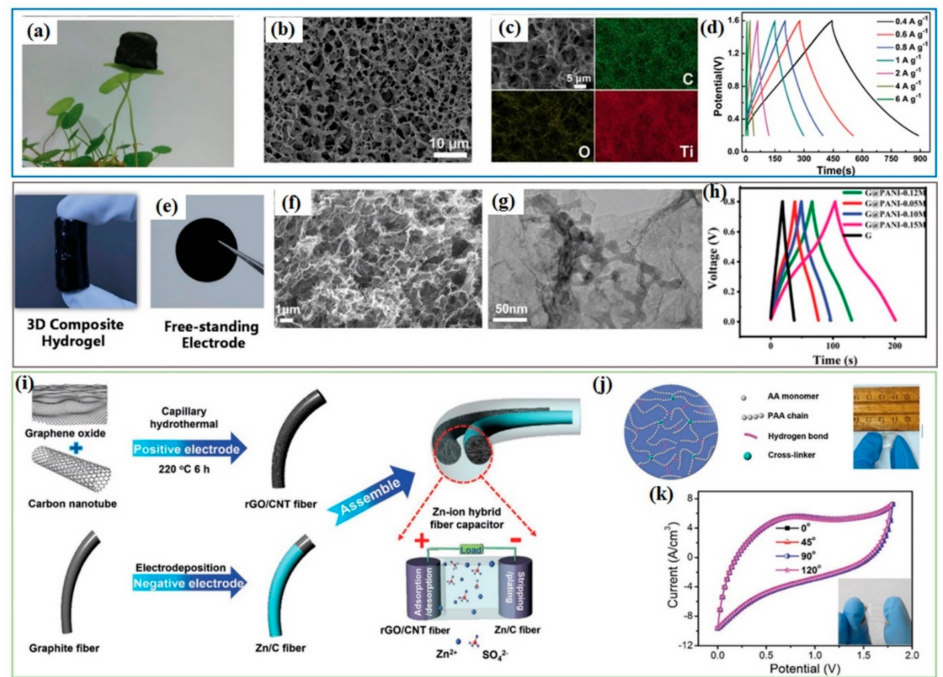
Figure 9. Graphene composites as cathodes for Zn-ion hybrid capacitors. ( a – d ) MXene@rGO aerogel for Zn-ion hybrid capacitors: ( a ) MXene-rGO aerogel standing on a piece of leaf, ( b ) SEM image, ( c ) EDS mapping, and ( d ) charge–discharge curves at current densities from 0.4 to 6 A g − 1 . Reproduced with permission [83], Copyright 2019, Wiley-VCH. ( e – h ) PANI@graphene hydrogel for a Zn-ion hybrid capacitor: ( e ) optical images of a 3D graphene hydrogel cylinder and the free-standing electrode film, ( f ) SEM and ( g ) TEM images of PANI@graphene, ( h ) galvanostatic charge–discharge profiles. Reproduced with permission [26], Copyright 2018, Royal Society of Chemistry. ( i – k ) CNT@rGO composite for Zn-ion hybrid fiber capacitors: ( i ) schematic illustration of the synthesis of CNT@rGO and the assembly of a Zn-ion hybrid fibre capacitor, ( j ) schematic illustration of a PAA hydrogel electrolyte and a photograph of a polyacrylic acid (PAA) electrolyte; ( k ) cyclic voltammetry (CV) curves of the flexible Zn-ion hybrid fibre capacitor when bent at different angles. Reproduced with permission [84], Copyright 2019,